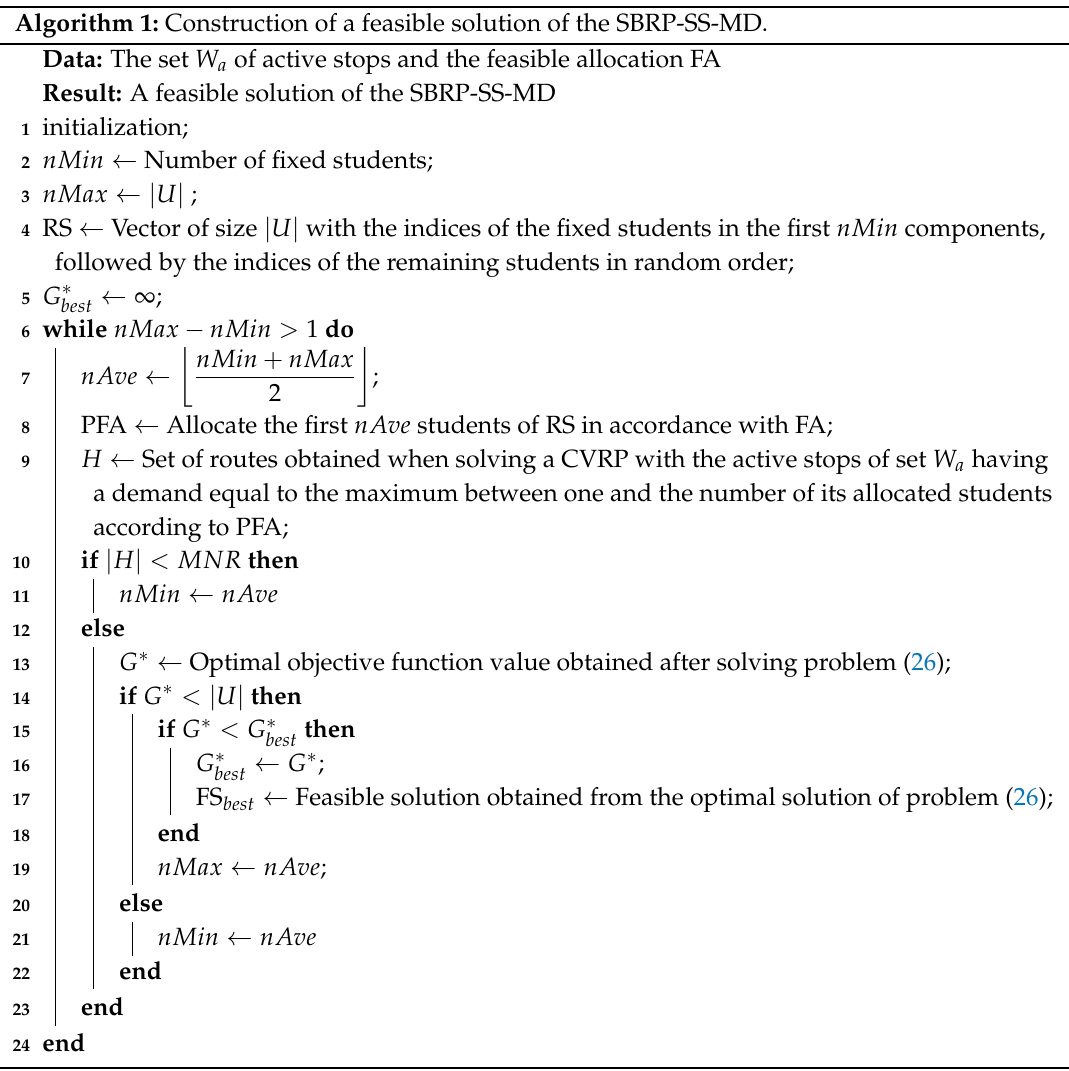
Algorithm 1: Construction of a feasible solution of the